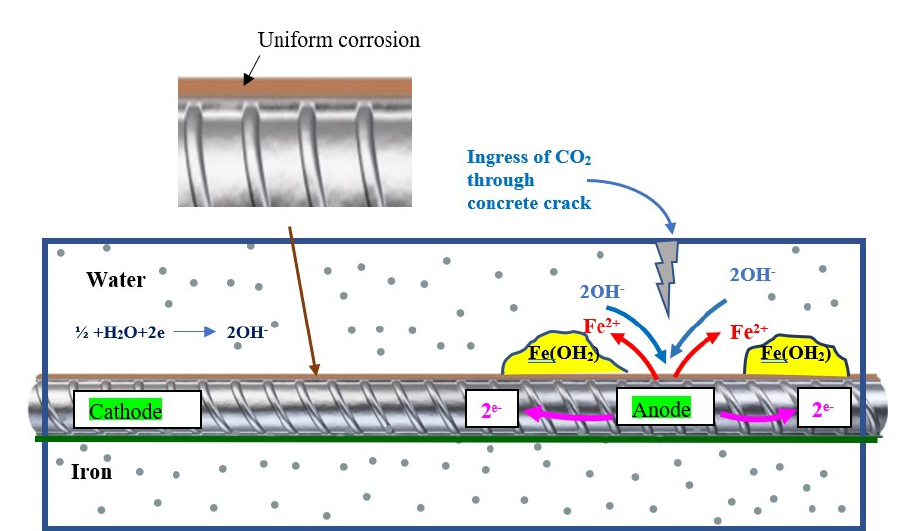
Figure 2. Mechanism of carbonation-induced corrosion.